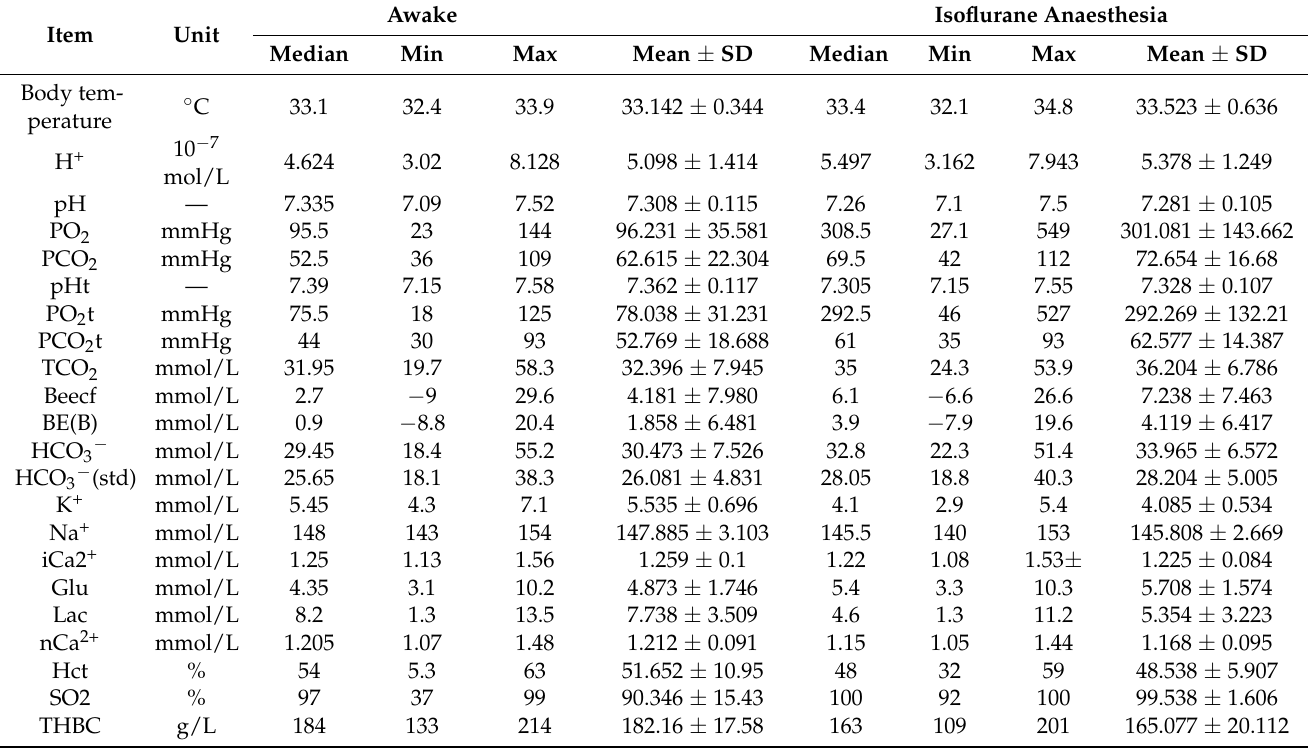
Table 2. Mean, standard deviation (SD), median, and range (Min–Max) of blood gas and lactate